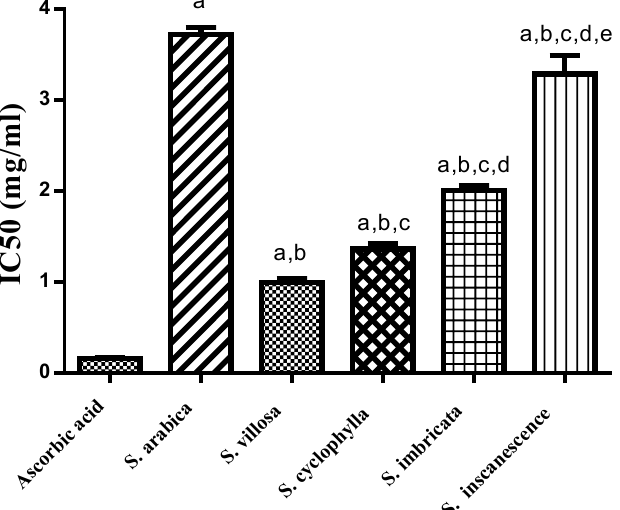
Figure 1. Anti-oxidant activity of n-hexane extracts of the five Salsola species using DPPH. Results were presented as mean ± SEM, n = 3, a Significantly different from ascorbic acid, b significantly different from S. arabica , c significantly different from S. villosa , d significantly different from S. cyclophylla , e significantly different from S. imbricata at p < 0.05.